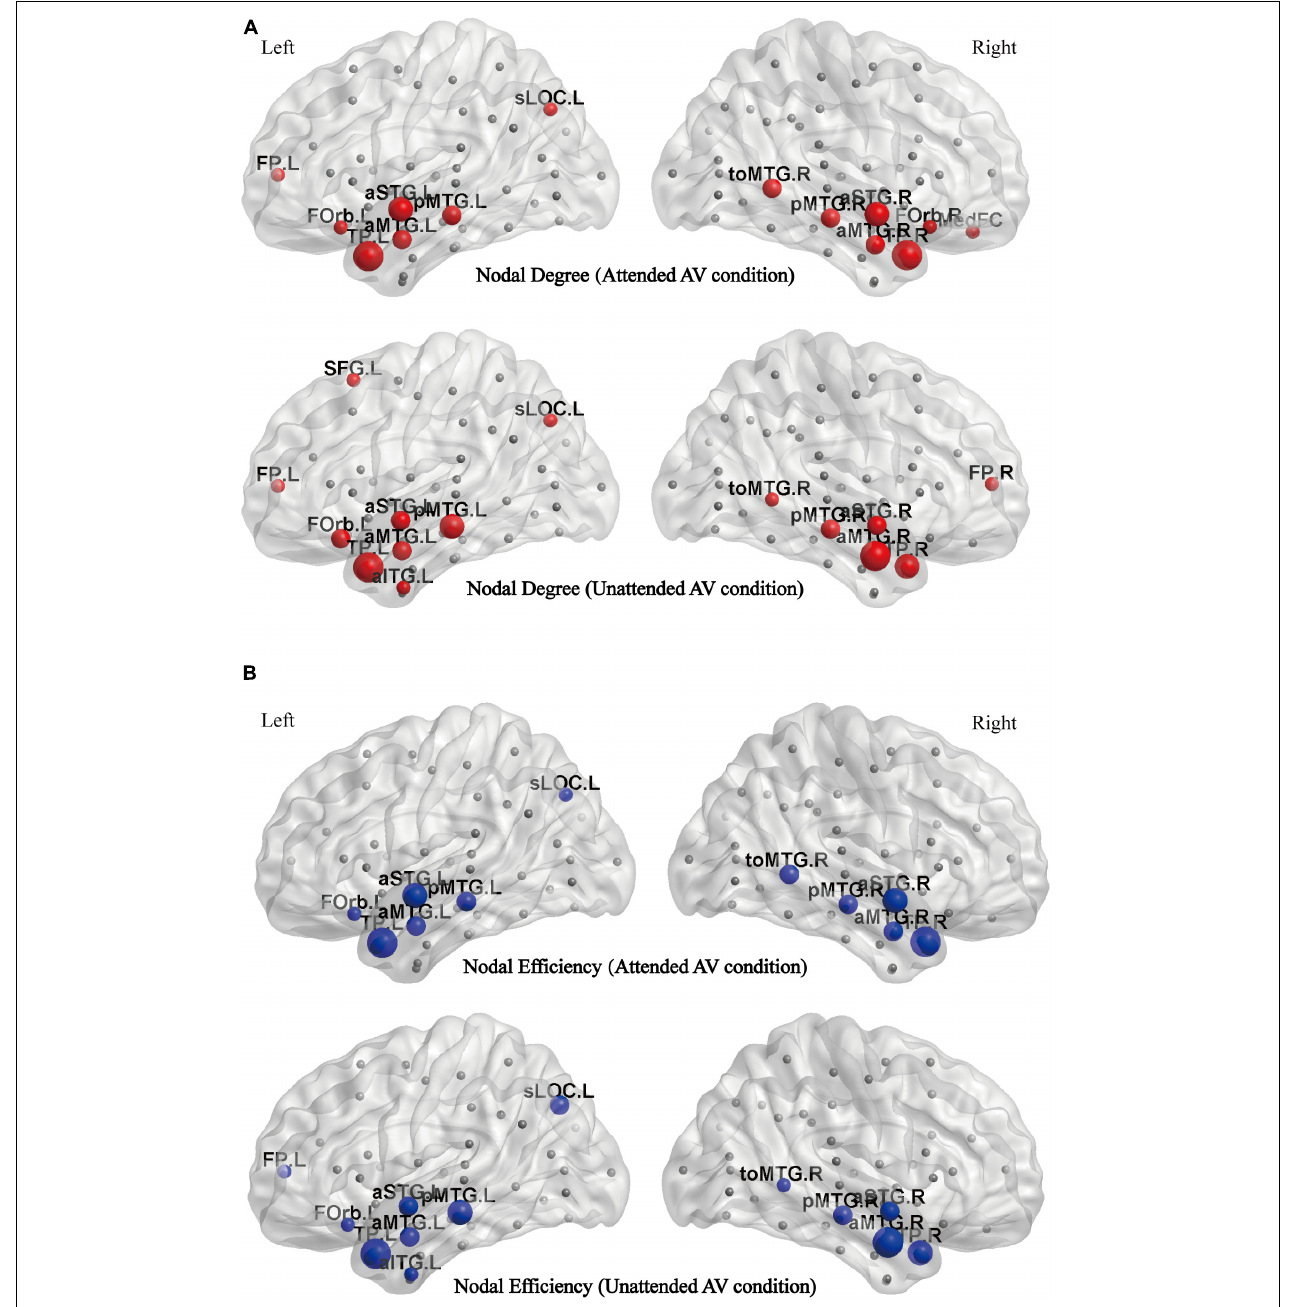
FIGURE 6 | (A) The distribution of hubs with a high nodal degree in the attended and unattended AV conditions mapped to the cortical surface. (B) The distribution of hubs with a high nodal efficiency in the attended and unattended AV conditions mapped to the cortical surface. aITG, inferior temporal gyrus; aMTG, anterior middle temporal gyrus; aSTG, anterior superior temporal gyrus; FOrb, frontal orbital cortex; FP, frontal pol; MedFC, medial frontal cortex; pMTG, posterior middle temporal gyrus; sLOC, superior lateral occipital cortex; SFG, superior frontal gyrus; toMTG, temporo-occipital middle temporal gyrus; TP, temporal pole; L, left; R,